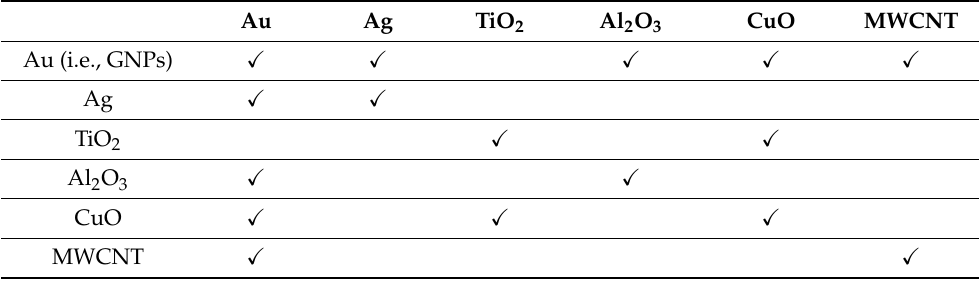
Table 1. The list of hybrid nanofluid. Au Ag TiO 2 Al 2 O 3 Au (i.e.,